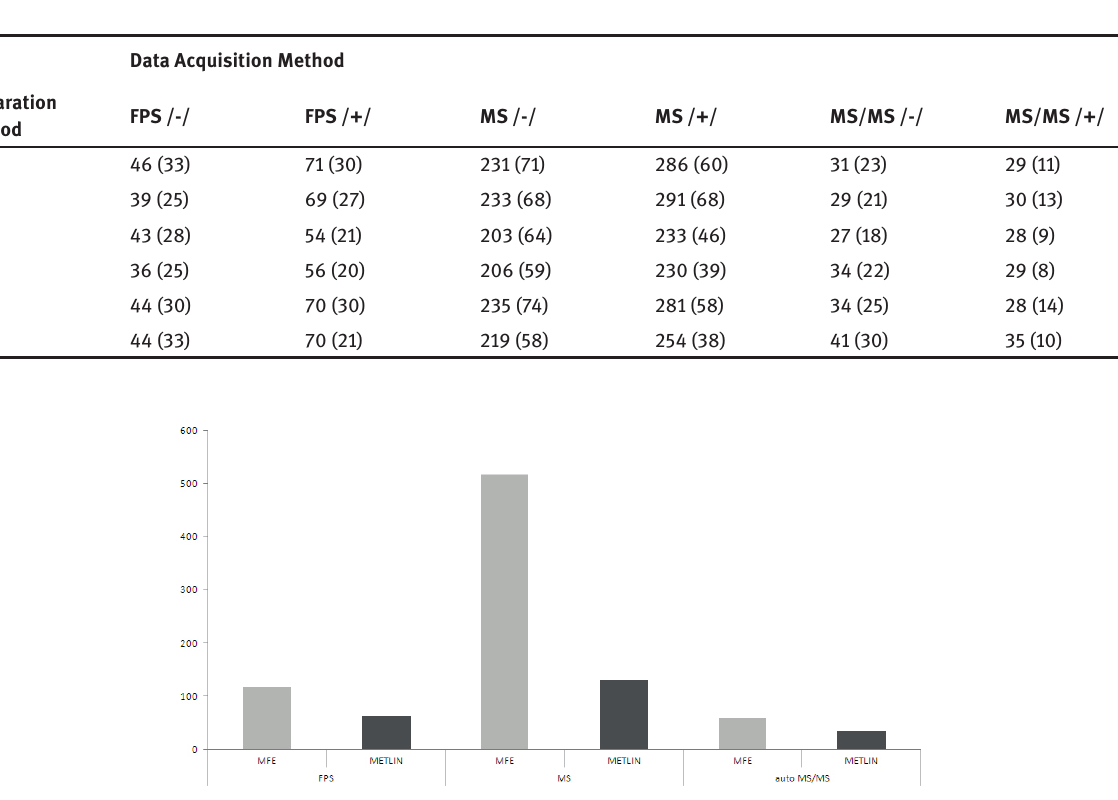
Table 1: Quantities of the generated compounds by MFE algorithm and matched by METLIN database (in parentheses) obtained for the tested preparation and data acquisition methods (separately for positive /+/ and negative /-/ ionization).